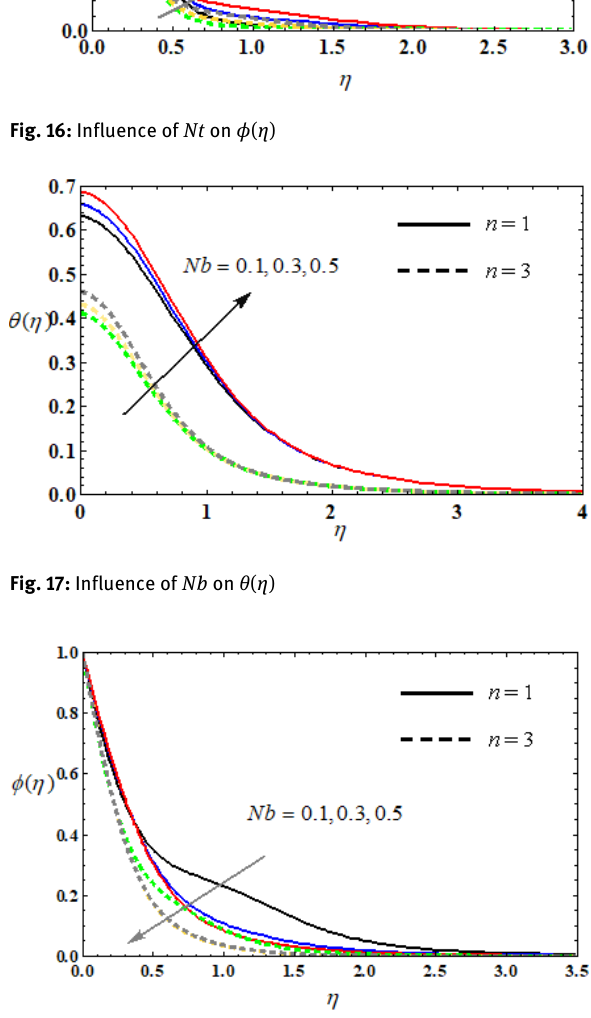
Fig. 18: Influence of Nb on ϕ ( η )